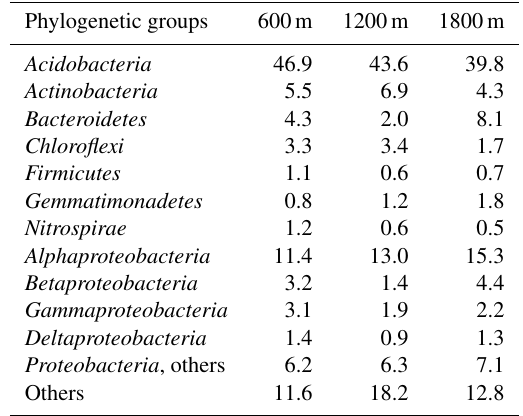
Table 1. Relative abundances (%) of different phylogenetic groups in the bamboo soil bacterial communities at different